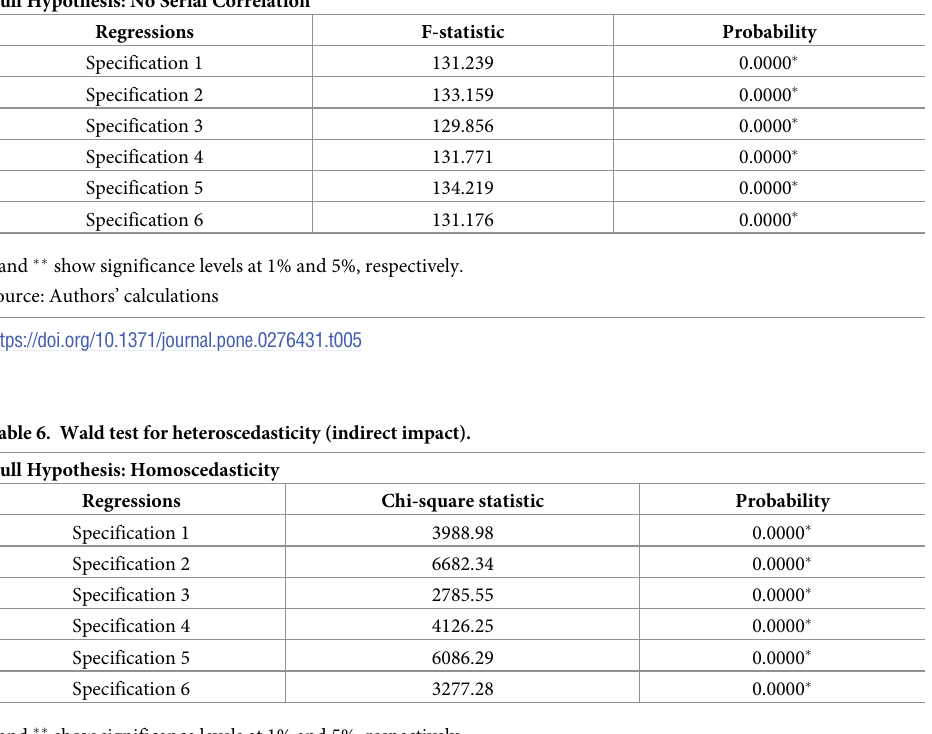
Table 5. Wooldridge test for serial correlation (direct impact). Null Hypothesis: No Serial Correlation